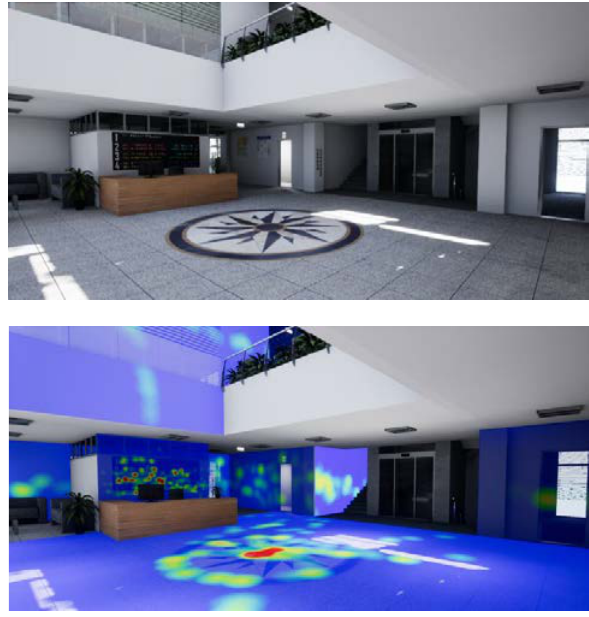
Figure 11-12: The entrance of the refurbished building and its